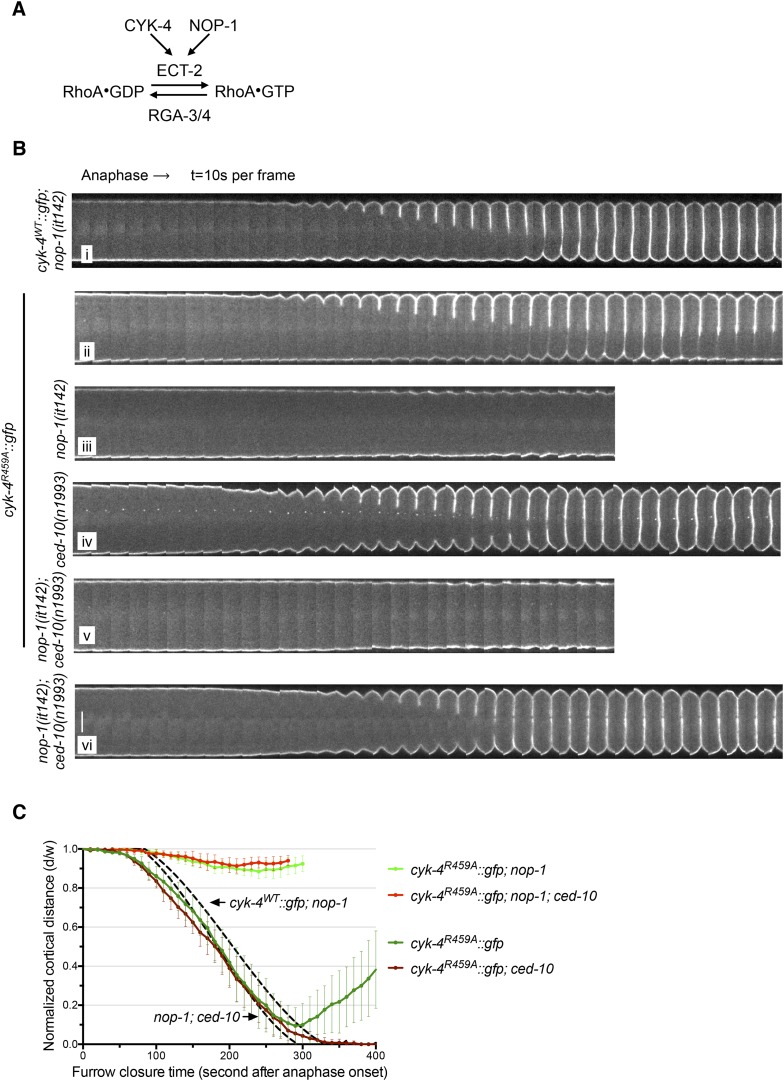
The GAP activity of CYK-4 is required for centralspindlin-dependent furrowing independent of CED-10/Rac1.(A) Schematic depiction of the known regulators of RhoA. (B) GAP defective CYK-4 causes cytokinesis defects that are greatly enhanced by loss of NOP-1 function; this defect is not fully suppressed by mutation of ced-10/rac1. Kymograph analysis of the progression of cytokinesis in CYK-4R459A embryos in the presence or absence of CED-10/Rac1 and/or NOP-1 function. The kinetics of furrow ingression in cyk-4WT::gfp; nop-1(it142) and nop-1(it142); ced-10(n1993) embryos are shown for comparison. Kymographs were assembled as described in legend to Figure 1D. (C) The kinetics of furrow ingression in CYK-4R459A embryos. Results are quantified as described in Figure 1G. The kinetics of furrow ingression in cyk-4WT::gfp; nop-1(it142) and nop-1(it142); ced-10(n1993) embryos from Figures 1F, 3F are shown as dashed lines for comparison.